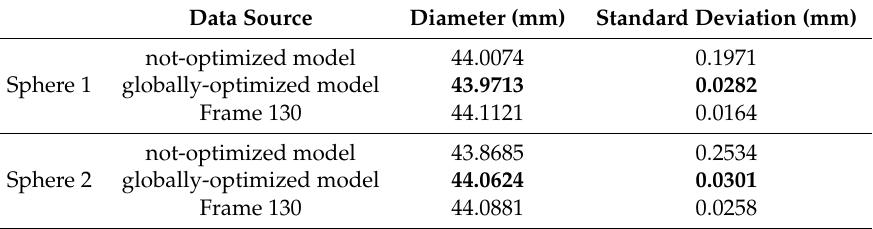
Table 1. Comparison of the diameter and standard deviation fitting results between not-optimized and globally-optimized model.